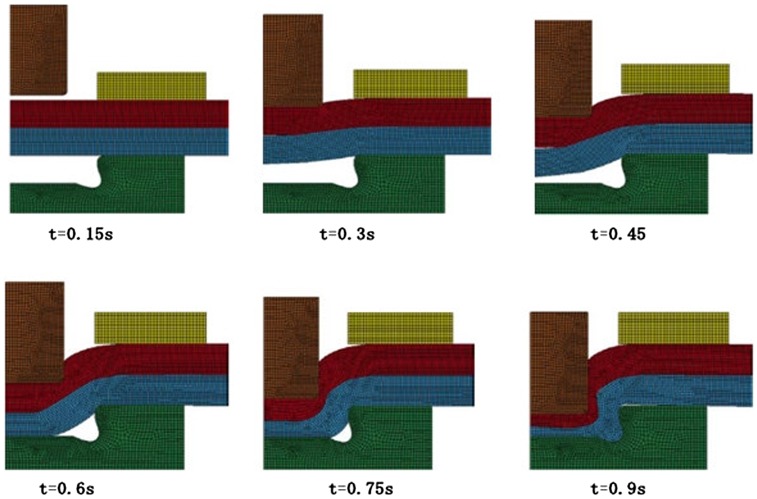
FE simulation of the clinching process [63].